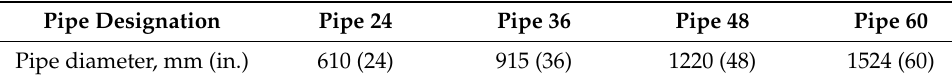
Table 1. Dimensions of the pipes used in the analysis.